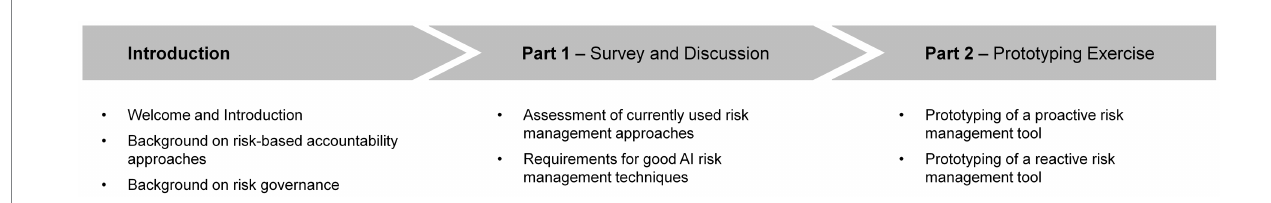
FIGURE 4 Agenda for the ‘Risk Management and Responsibility Assessment for AI Systems’ workshop.